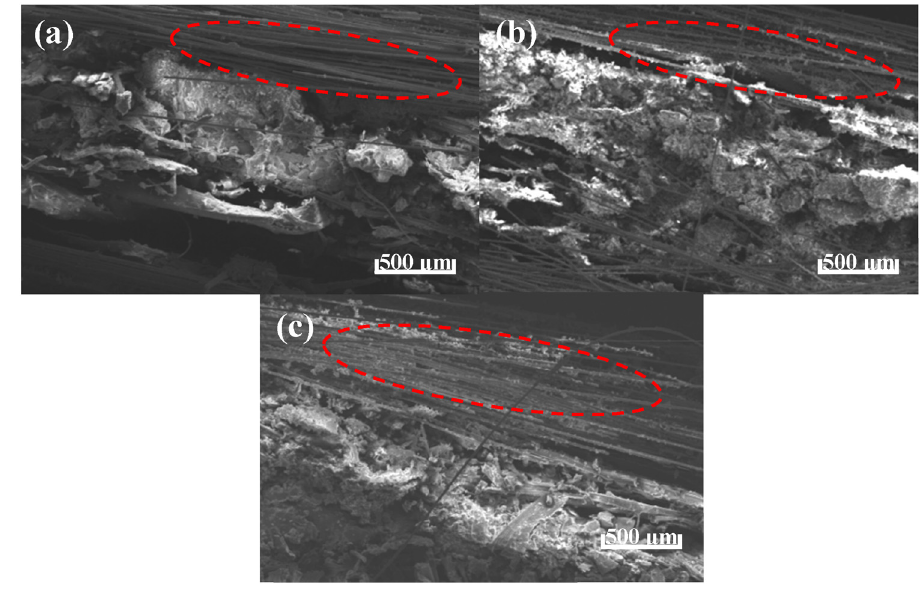
Figure 12: SEM micrographs of composites: ( a ) UBF/HF/PLA, ( b ) CBF/HF/PLA, and ( c )